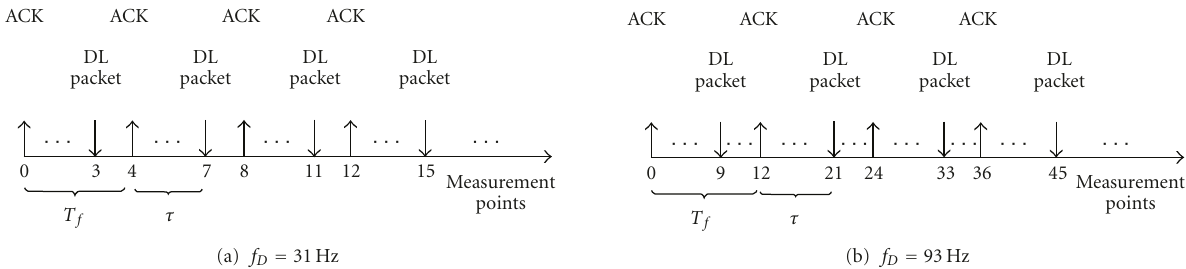
Figure 16: Uplink and downlink MIMO positions for the di ff erent f D .